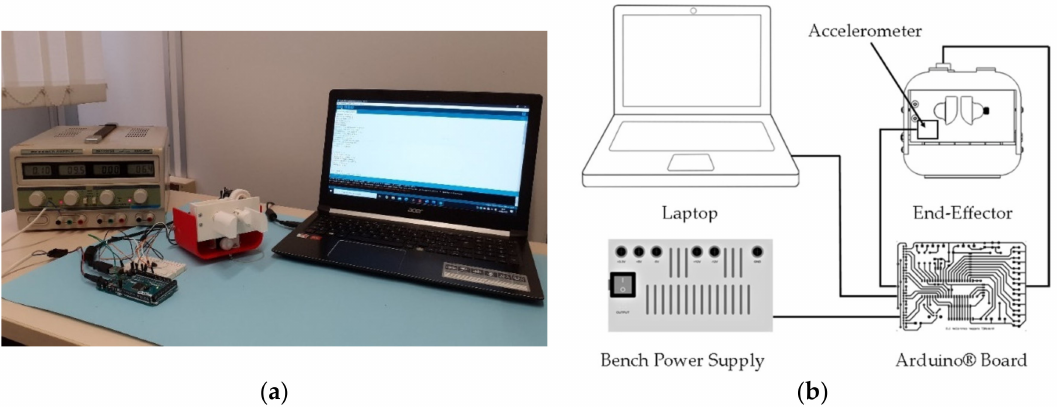
Figure 13. Experimental setup: ( a ) laboratory view; ( b ) setup